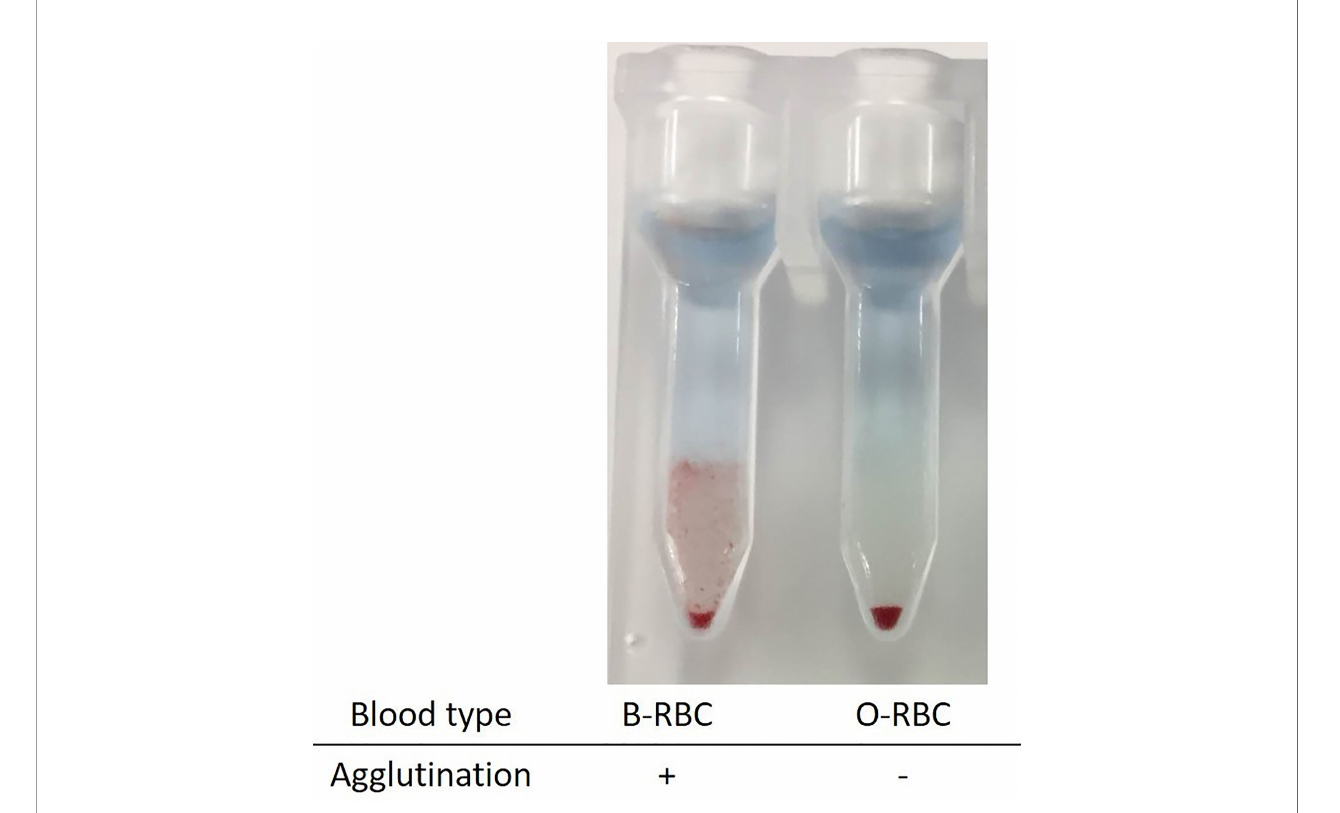
FIGURE 2 | Indirect Coombs test with the eluates from donor T lymphocyte. Donor lymphocytes were incubated with recipient sera, and attached antibodies were extracted into an acidic solution. The eluate was mixed with red blood cells of types B and O. Only the former agglutinated, implying the existence of type B material on the donor T